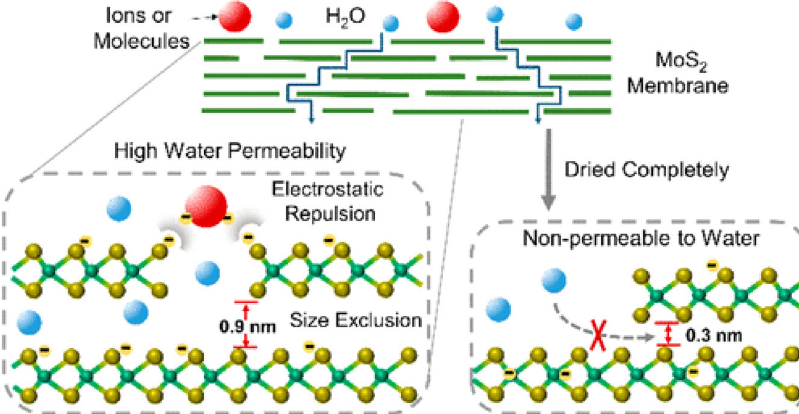
Fig. 5 MoS 2 membranes size of their different hydration states nanochannels. Reproduced with permission from Nano Lett. 17, 12 (2017). Copyright 2017 American Chemical Society 65 .